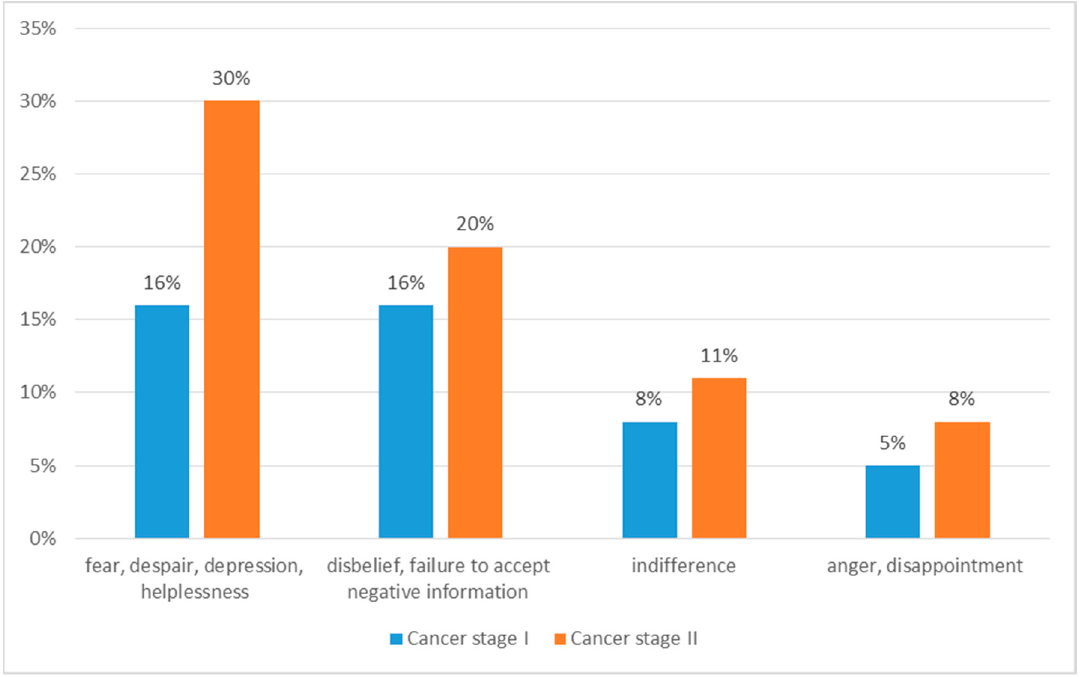
Figure 3. Patients’ responses to the diagnosis of cancer by cancer stage.